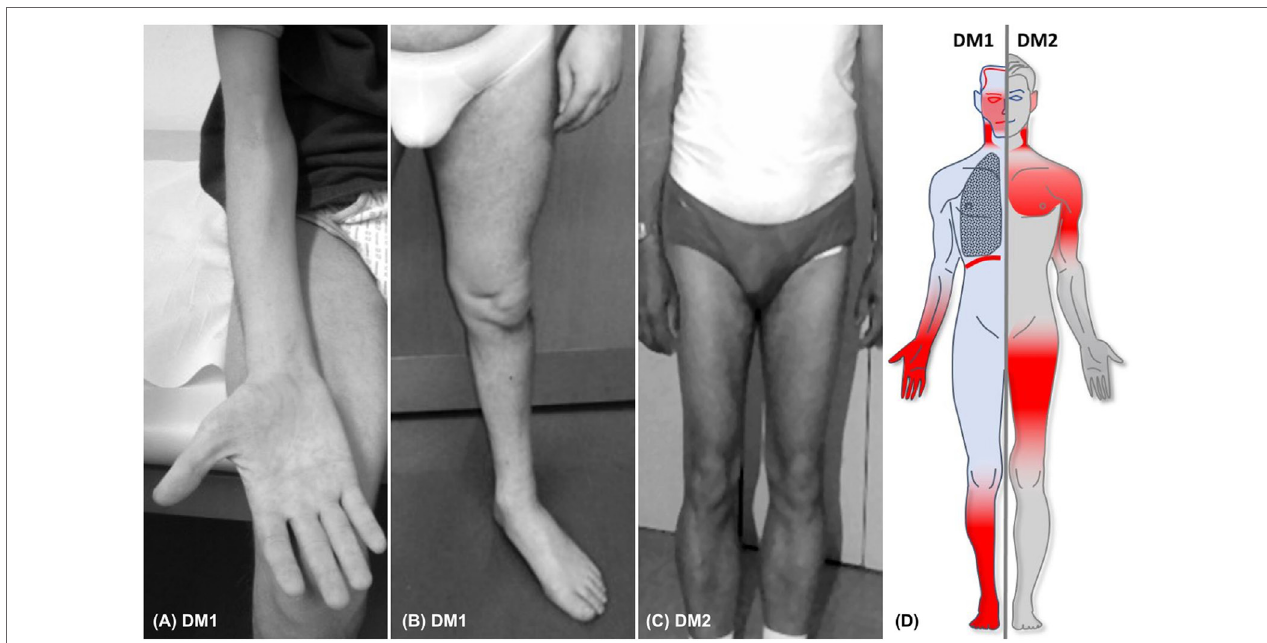
FiGURe 1 | (A,B) Typical distal muscular atrophy in patients with DM1. (C) Atrophy of proximal muscles in a patient with DM2. (D) Figure illustrating the core phneotypes of DM1 (left) and DM2 (right). Regions of muscular involvement (weakness and atrophy) are highlighted in red.